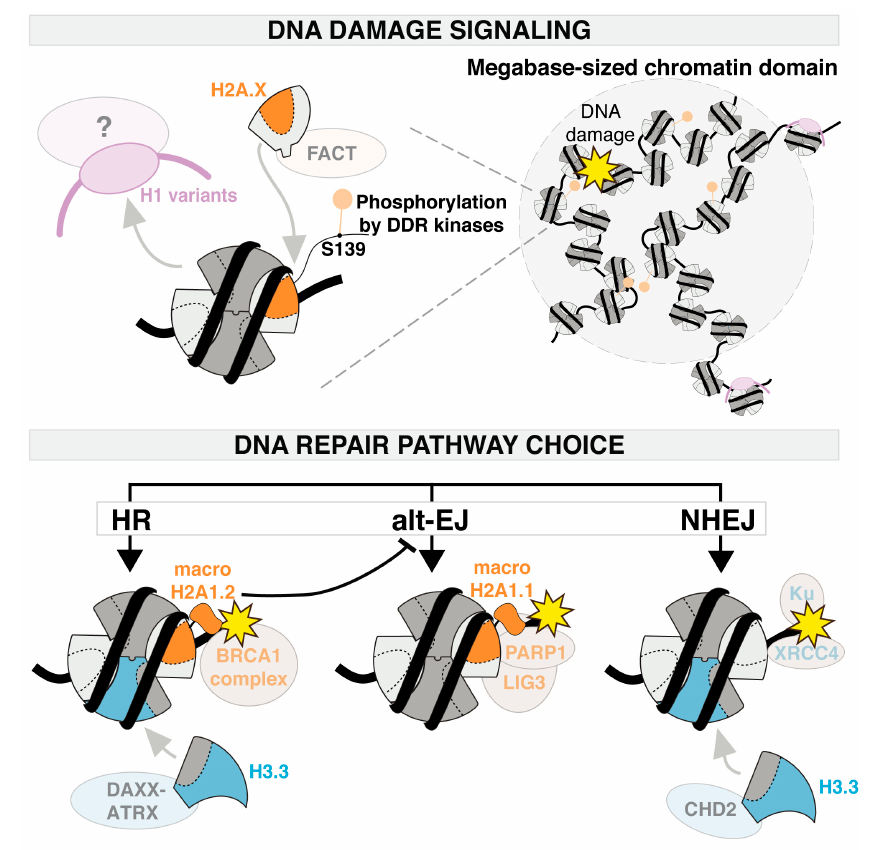
Figure 3. Histone variant roles in DNA damage signaling and repair pathway choice. DNA damage signaling is stimulated by the eviction of H1 histone variants and by the phosphorylation of H2A.X. Prior to phosphorylation, H2A.X is deposited de novo in damaged chromatin by the histone chaperone FACT. These alterations in histone variants span megabase chromatin domains around DNA lesions. H3.3 and macroH2A histone variants drive DSB repair pathway choice by promoting the recruitment of specific repair factors. The H2A.Z variant is not included in this scheme because of conflicting results regarding its impact on DSB repair. DDR: DNA damage response; HR: homologous recombination; alt-EJ: alternative end joining; NHEJ: non-homologous end joining.